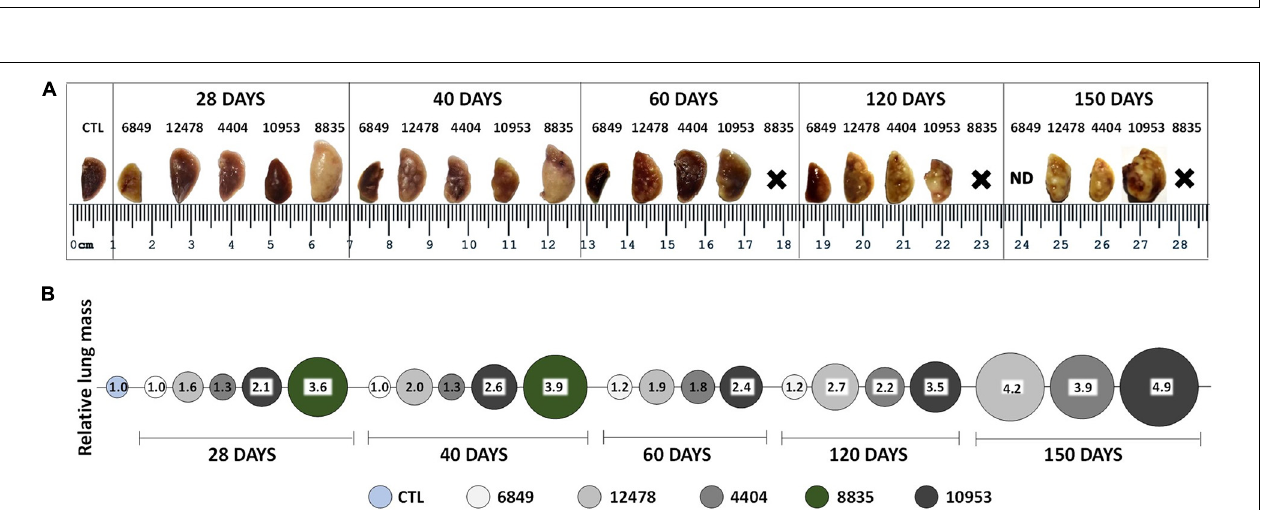
FIGURE 3 | Morbidity and mortality of mice after challenge with Mycobacterium kansasii strains. C57BL/6 mice were infected intratracheally with 5 × 10 4 bacilli of each strain and the disease progression was studied within a 150-day period. (A) Body weight loss was used as an indicator of morbidity. Data are presented as the percentage of initial body weight of each animal prior to infection. Values were reported as mean ± standard deviation, SD, and the differences were considered significant according to *** P < 0.001; ** P < 0.01; and * P < 0.05. (B) Survival of the infected animals. The data were obtained in three independent experiments with 10 mice in each group. Kaplan-Meier curves and log rank test were used to evaluate statistical significance. Statistically significant differences between each group infected with the individual clinical isolate and the group infected with reference strain 12478 are presented by symbol ### P < 0.001. (C) Bacterial loads in the lungs were assessed by CFU assay. The data were obtained in three independent experiments with 12–15 mice in each group: 2–3 animals per point. Values were reported as mean ± SD. Mean values that were significantly different from the mean value of the group infected by reference strain 12478 are indicated by asterisks as follows: *** P < 0.001 and ** P < 0.01. Significant differences between values obtained for each group at different time points are indicated by symbol ### P < 0.001.